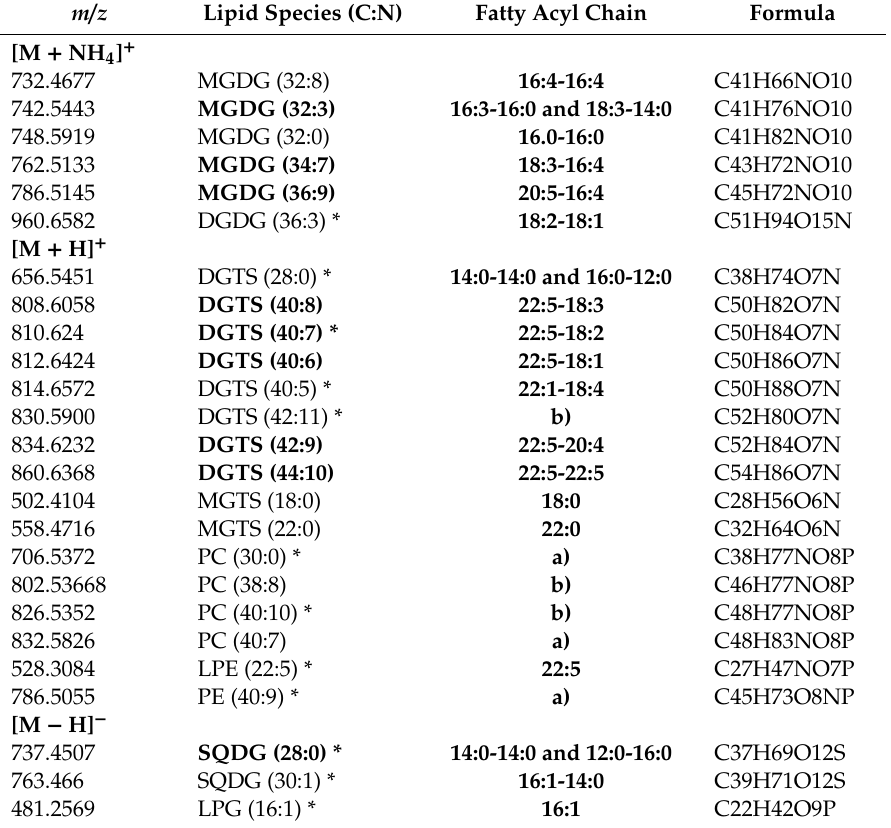
Table 2. Top 25 lipid species sorted by Tukey’s HSD test displaying the lowest q-values. Lipid molecular species were identified by HILIC-ESI-MS and assigned by MS / MS. MGDG and DGDG were identified by HILIC-ESI-MS as [M + NH 4 ] + ions; DGTS, MGTS, PC, PE and LPE were identified as [M + H] + ions; SQDG and LPG were identified as [M − H] − ions. Labels of lipid species are according to the notation: AAAA (C:N), (AAAA, lipid class; C, total carbon atoms; N, total double bonds of fatty acid substituents). (a) Lipid molecular species identification was based on retention time and mass accuracy. (b) Lipid molecular species identification included MS / MS based analysis using diagnostic ions. Asterisked samples refer to specific lipid molecular species represented in Table